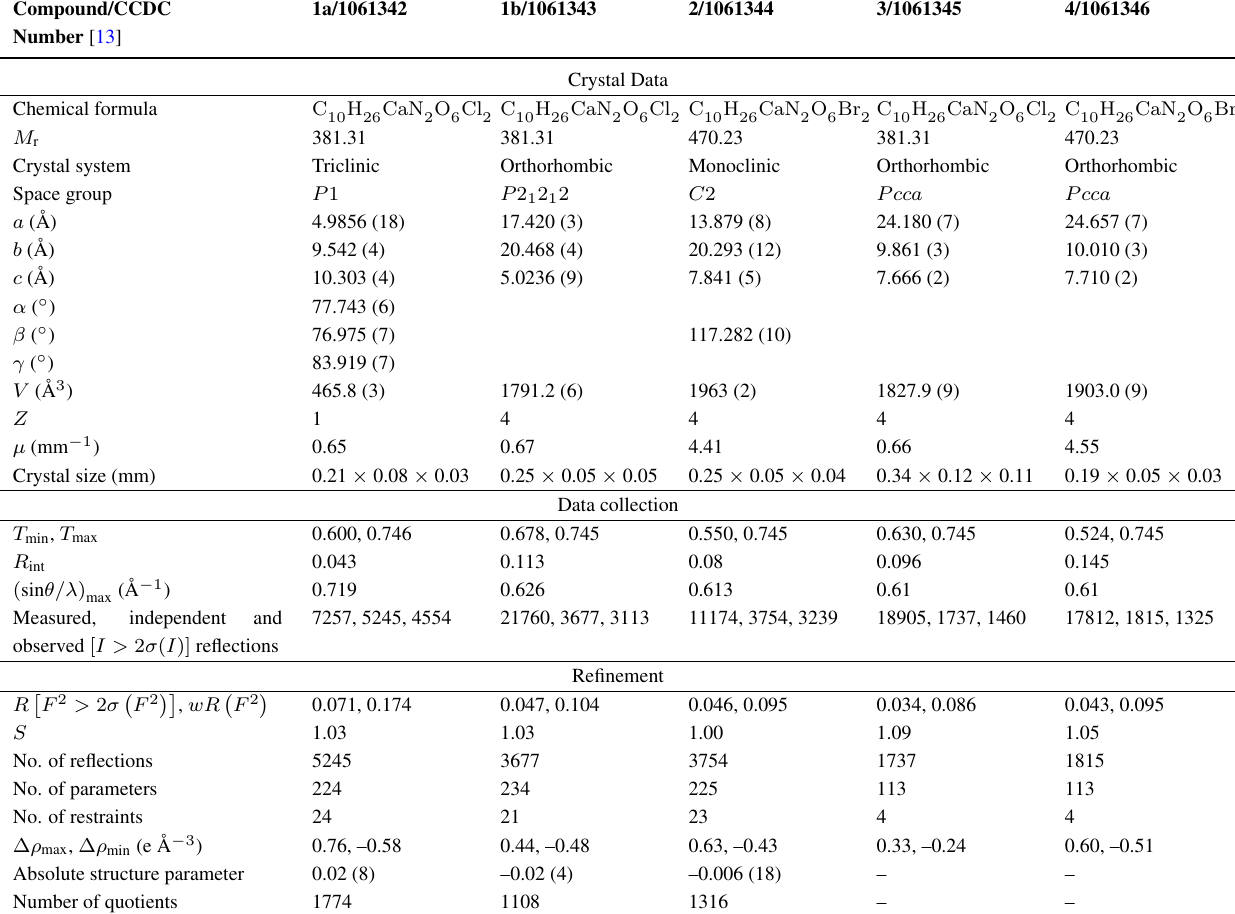
Table 1. Data collection and refinement details for all